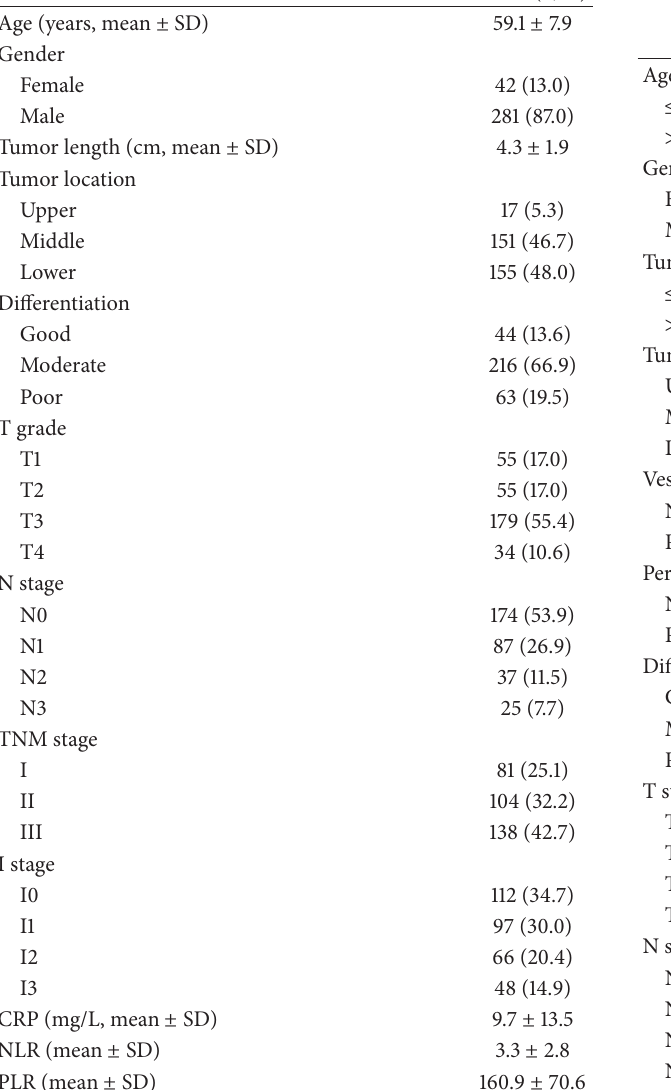
Table 1: Clinicopathological characteristics for patients with ESCC. Table 2: The relationship between I stage and clinicopathological